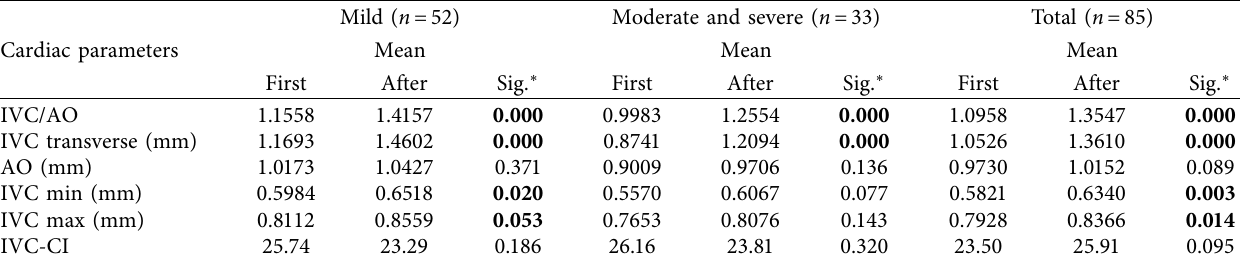
Table 2: Comparison of sonographic parameters before and after fluid therapy. Cardiac